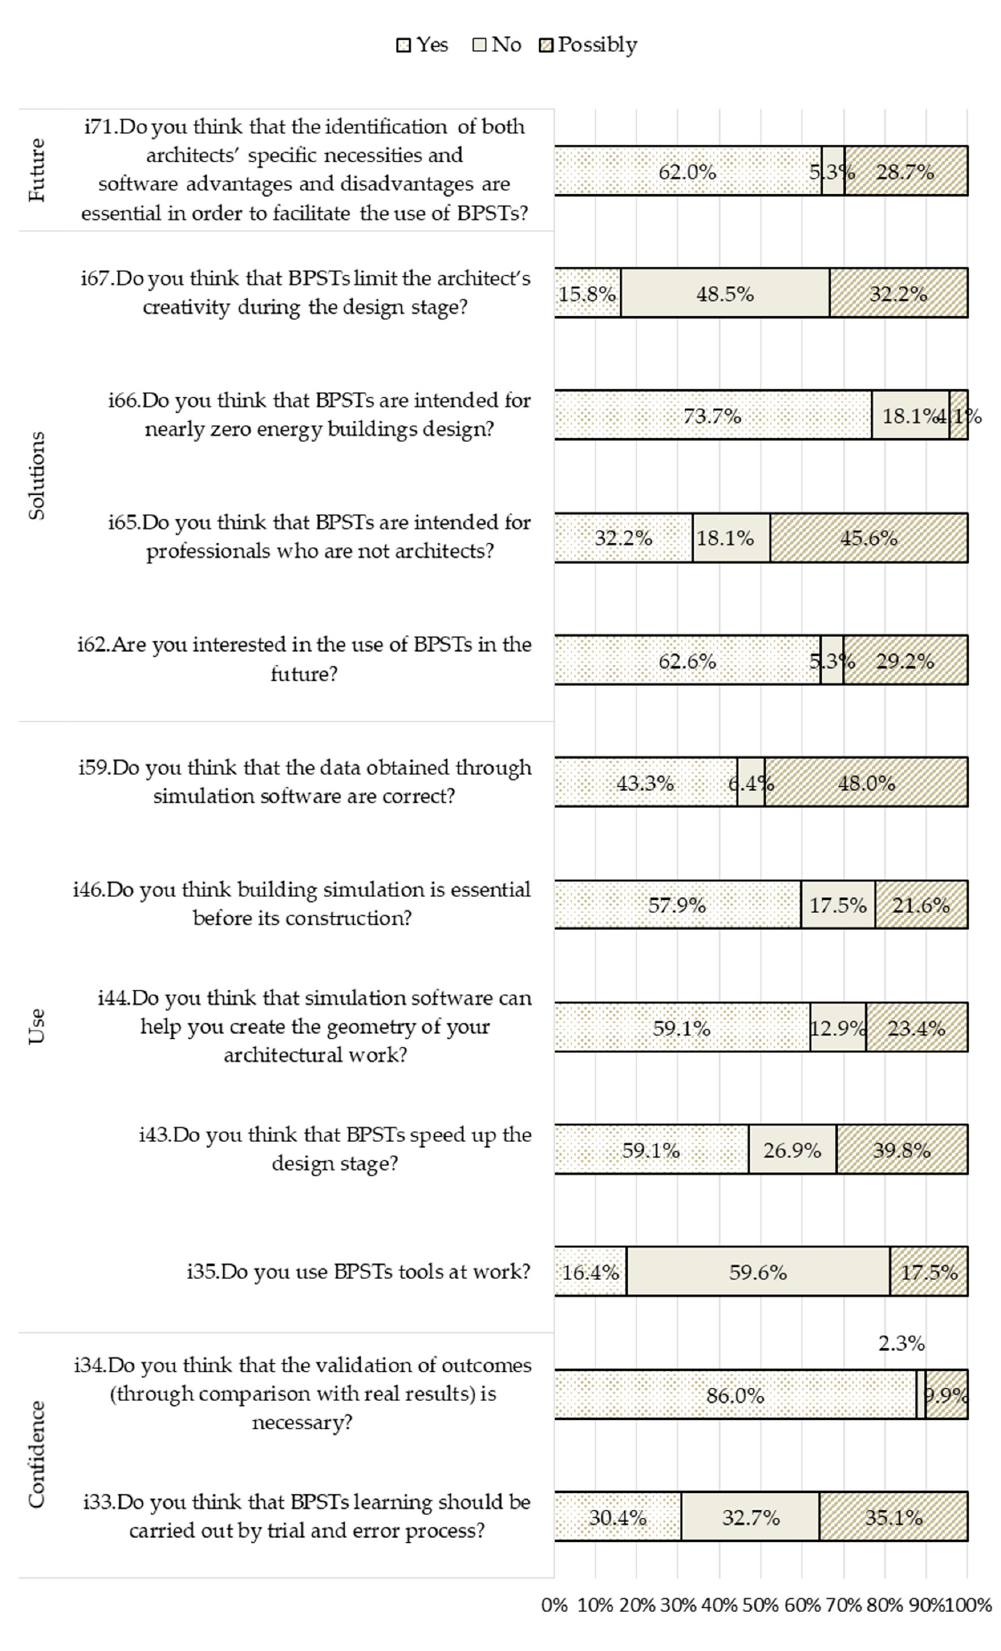
Figure 4. What are the reasons for and against using BPSTs? (Addressed to non-users and users).